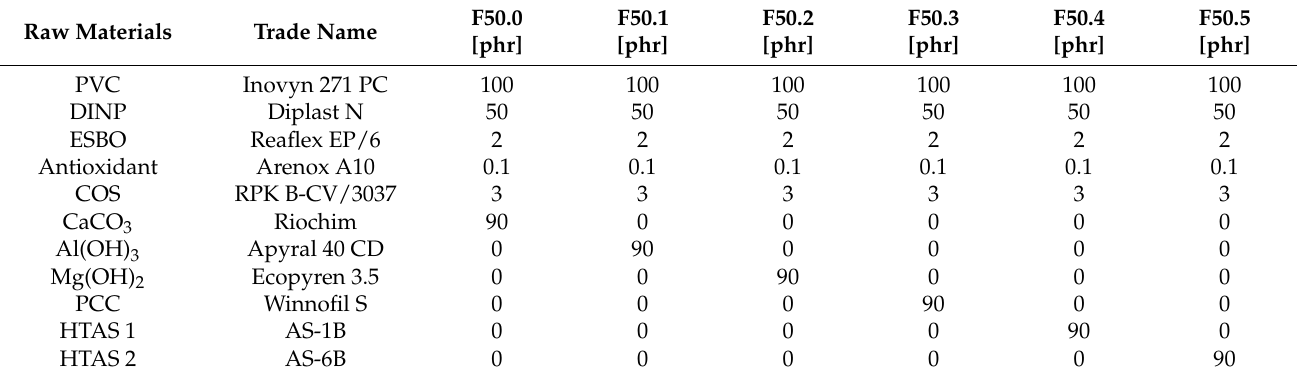
Table 1. First series of formulations: DINP means Di Iso Nonyl Phthalate. ESBO stands for Epoxidized Soy Oil Bean. The used antioxidant is Arenox A10, which is Pentaerythritol tetrakis(3-(3,5-di-tert- butyl-4-hydroxyphenyl)propionate), CAS number 6683-19-8. COS stands for Calcium Organic Stabilizer. PCC means Precipitated Calcium Carbonate. AS-1B and AS-6B are potent acid scavengers at high